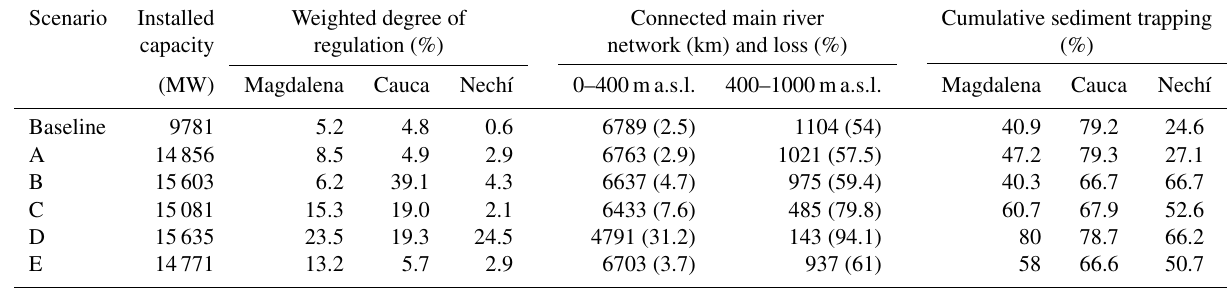
Table 2. Indices of basin-level cumulative alteration of selected scenarios at Mompós Depression boundary conditions. Percentage loss of the connected main river network in parentheses. See Fig. 5 for station locations.